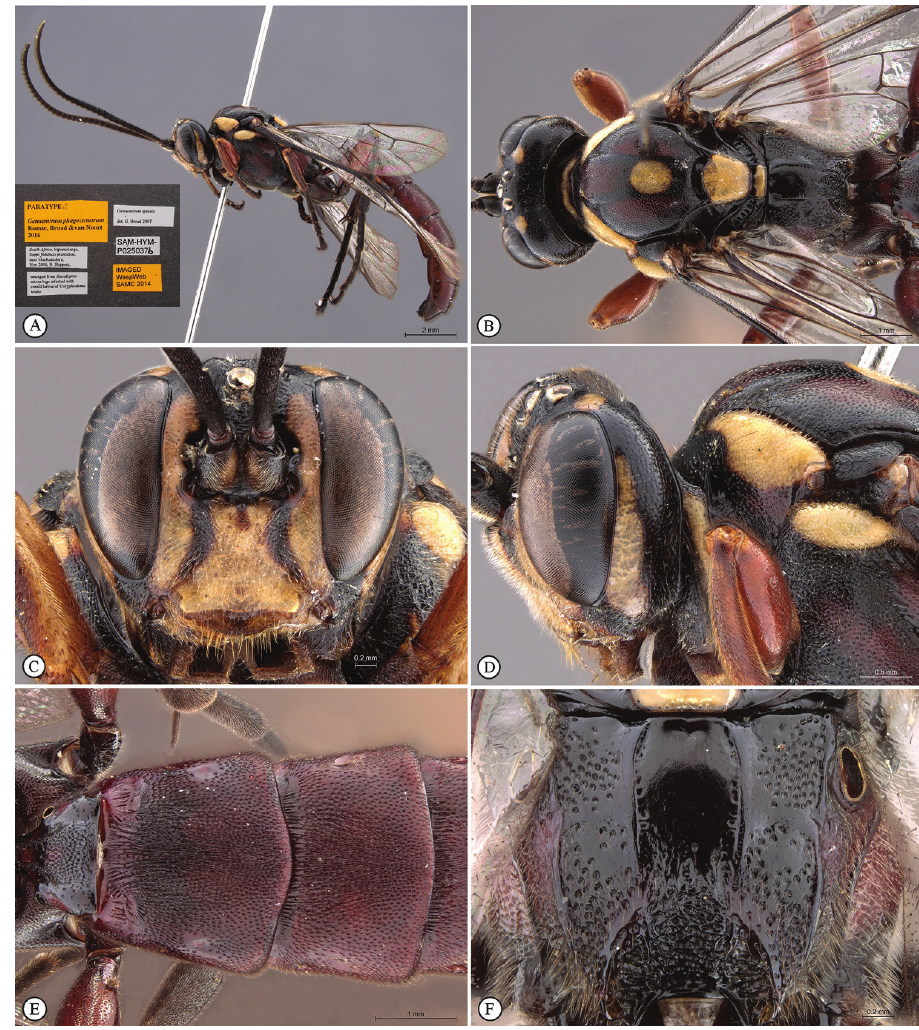
Figure 2. Genaemirum phagocossorum sp. n. Paratype male. A habitus lateral view (inset: data labels) B head, mesosoma, dorsal view C head anterior view D head, mesosoma anterior-lateral view E metasomal tergites 1-4 dorsal view F propodeum, dorsal